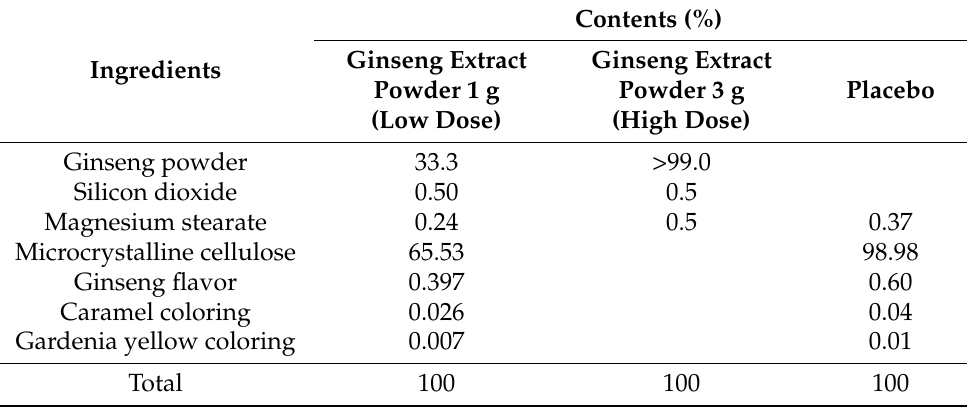
Figure 1. HPLC chromatogram of the freeze-dried hot-water extracts (GE) from Panax ginseng (4 years old). Table 1. Composition of the test and placebo